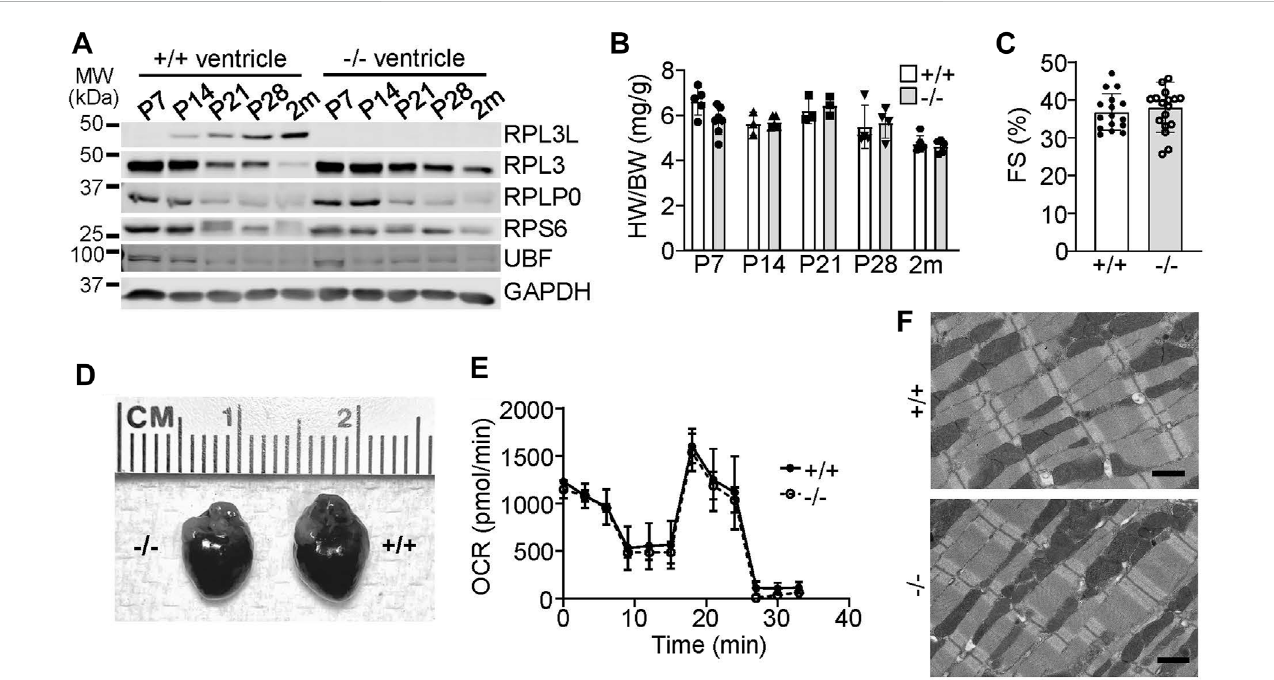
FIGURE 2 RPL3L and RPL3 protein expression switch during development in themouse heart. (A) Westernblotting for the indicated proteins at theindicated times after birthfromhearts ofwildtype(+/+) or Rpl3l − / − ( − / − )mouse ventricles. GAPDHisusedas aprocessing and loadingcontrol.MWdenotesmolecular weight in kilodaltons (kDa). (B) Heart weight to body weight ratios in wild type (+/+) or Rpl3l − / − ( − / − ) mice over the indicated developmental time points ( n = 3 – 7 per group). (C) Fractional shortening (FS) measured by echocardiography at 2 months of age in wild type and Rpl3l − / − ( n = 16 – 17). (D) Gross morphological images of hearts from wild type or Rpl3l − / − mice at 2 months of age. (E) Oxygen consumption rate (OCR) of isolated cardiac mitochondria from hearts of the indicatedtwogroups ofmiceat2 monthsofage( n =3).The OCRexperimentextended overtime (min)with sequentialadditionofrespiratorychaincomplex inhibitors at the different in fl ection points in the curves shown. (F) Electron micrograph showing sarcomeric and mitochondrial ultrastructure in heart histological sections in 2-month-old mice (scale bars = 1 µm). All data are represented as mean ±